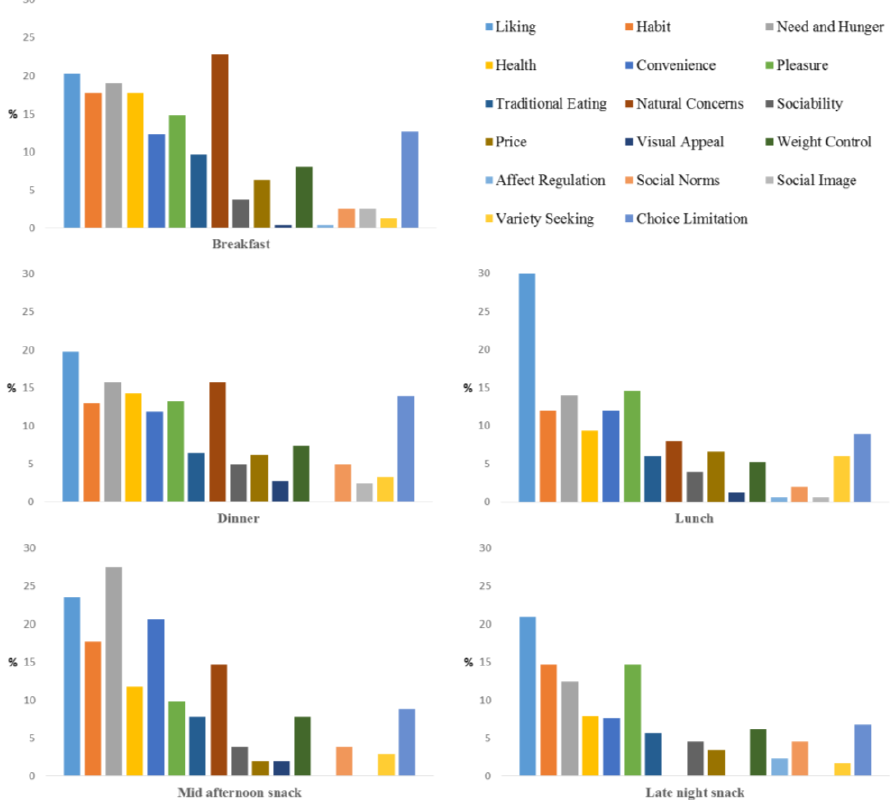
Figure 5. Frequency of responses (%) of 17 motivations for each eating occasion.